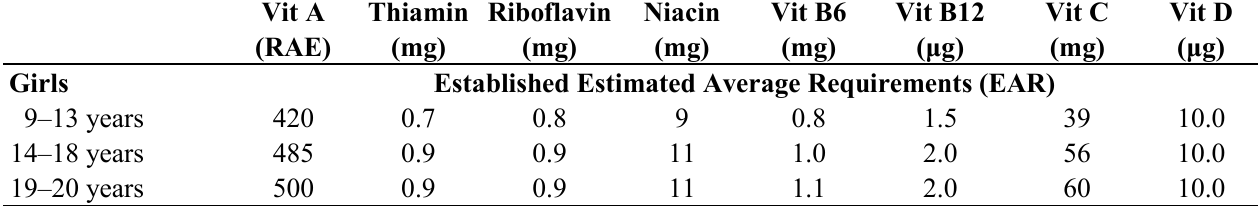
Table 1. Mean micronutrient intake and percent of girls meeting estimated average requirements (EAR), stratifying by age and